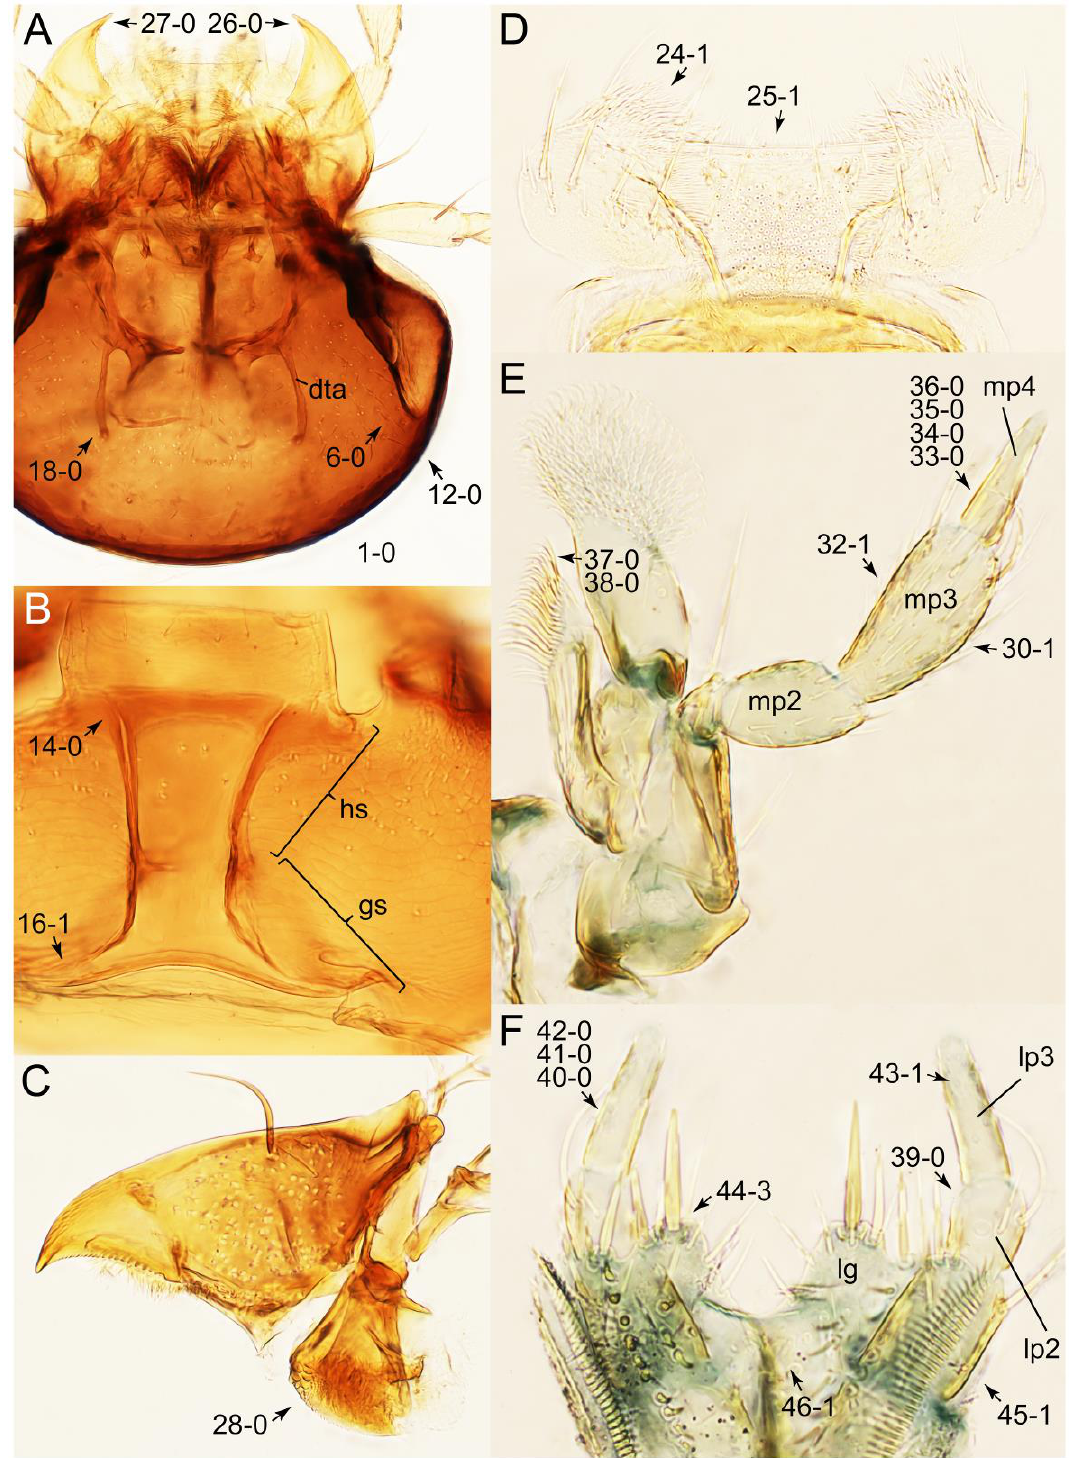
Figure 16. Photographs of body parts of Tachyporini: Euconosomatina, enlarged. ( A ) head of Sepedophilus littoreus , dorsal view. ( B ) hypostomal and gular sutures of Sepedophilus bisignatus , ventral view. ( C ) right mandible of Sepedophilus littoreus , dorsal view. ( D ) labrum of Sepedophilus crassus , dorsal view. ( E ) left maxilla of Sepedophilus scriptus (Horn), ventral view. ( F ) labium of Sepedophilus cinctulus , dorsal view. Abbreviations: dta, dorsal tentorial arm; gs, gular suture; hs, hypostomal suture; lg, ligula; lp2–3, labial palpomere 2–3; mp2–4, maxillary palpomere 2–4. Characters and character states (format X-X) are indicated on each